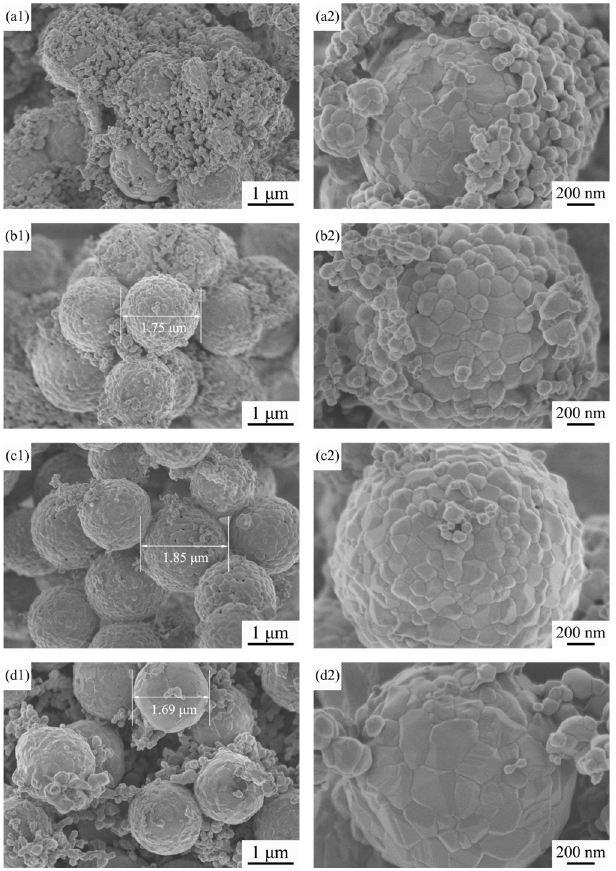
Figure 6. FE-SEM images of the intermediate microspheres after calcination at 800 °C for different Co/Ni molar ratios: ( a1 , a2 ) 0.1:0.9, ( b1 , b2 ) 0.3:0.7, ( c1 , c2 ) 0.7:0.3, ( d1 , d2 ) 0.9:0.1.